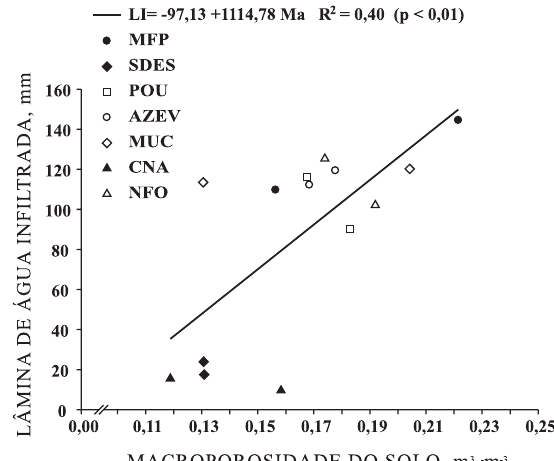
Figura 3. Relação entre macroporosidade média da camada de 0,0–0,20 m e a lâmina total de água infiltrada em um Argissolo Vermelho submetido a diferentes sistemas de culturas em plantio direto, após 16 anos de experimentação. (MFP: milho + feijão-de-porco/soja; SDES: solo descoberto; POU: milho/pousio/soja; AZEV: milho/azevém + ervilhaca/soja; MUC: milho + mucuna/soja; CNA: campo nativo; NFO: milho/ nabo